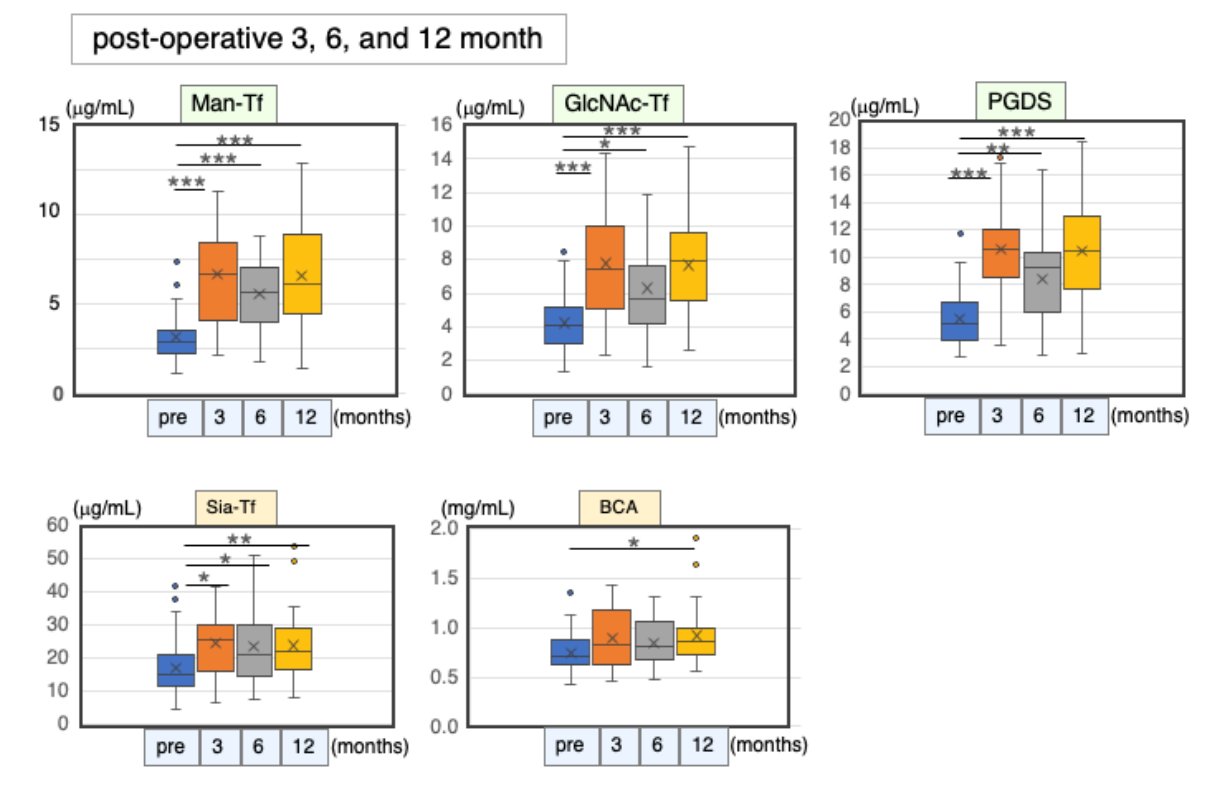
Figure 9. CSF marker levels at post-operative months 3, 6, and 12. Horizontal lines within boxes show median values; boxes exclude upper and lower interquartile ranges; whiskers indicate maximum and minimum values. Outliers are indicated by dots. Probability level: * p < 0.05, ** p < 0.01, *** p < 0.001. Table 11. CSF marker levels at post-operative months 3, 6, and 12.